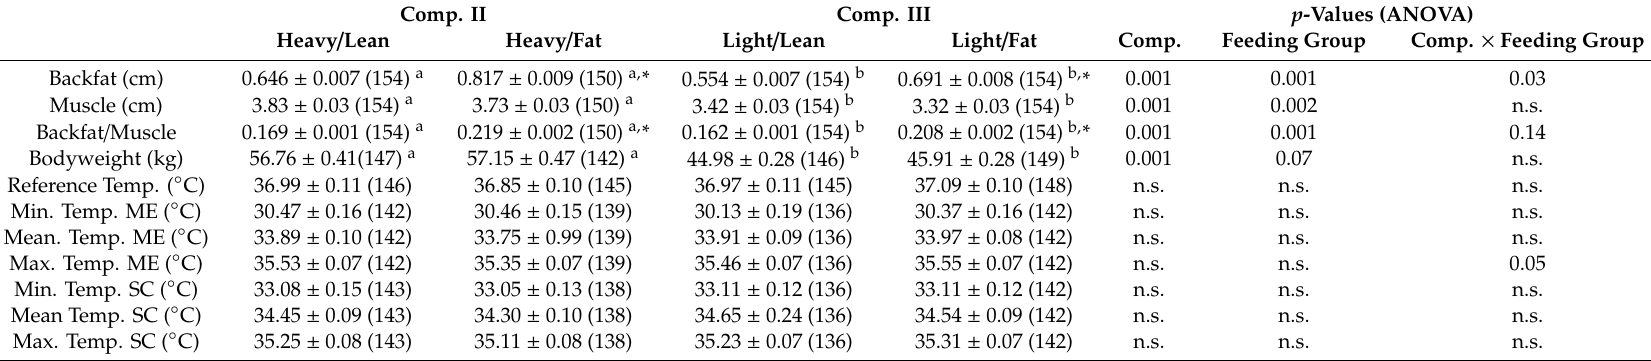
Table 5. Body condition values and body surface temperatures (mean ± SE ( n )) for compartment II and III on measurement day 1, according to the feeding groups. Comp. II Comp. III p -Values (ANOVA) Heavy / Lean Heavy / Fat Light / Lean Light / Fat Comp. Feeding Group Comp. × Feeding Group